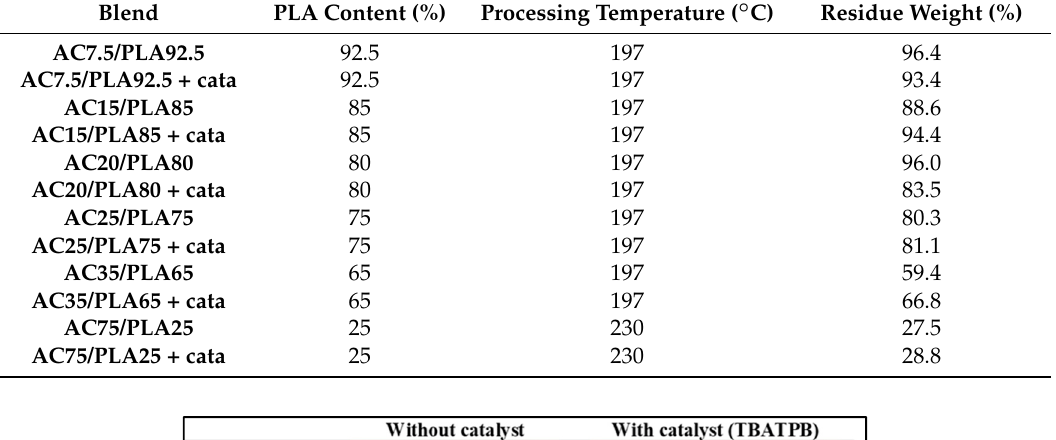
Table 3 . Results of dissolution tests performed on extruded strands of blends.